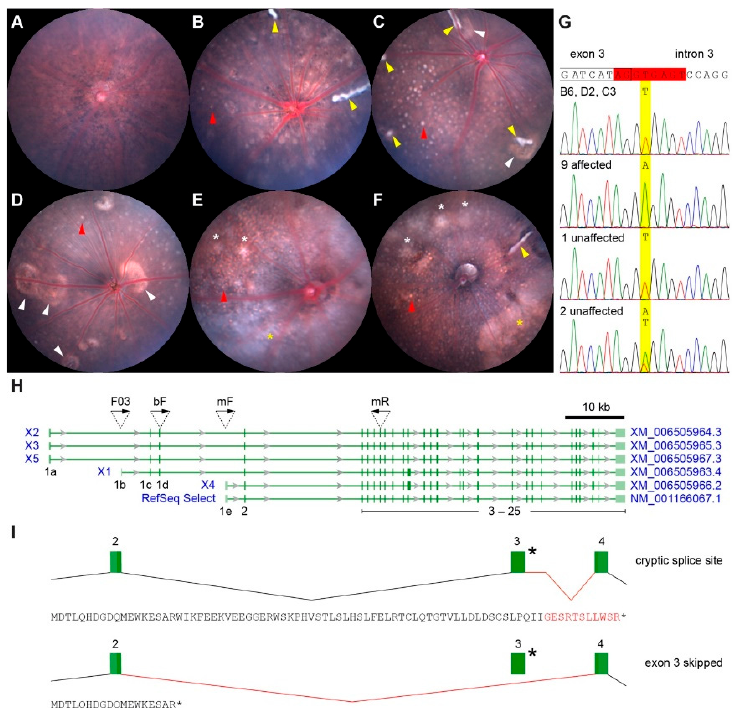
Figure 1. Representative fundus phenotypes of tvrm77 mice and identification of the causative mutation. ( A ) Bright-field fundus image of a female ( F ) B6 mouse at 1 month of age. ( B – F )